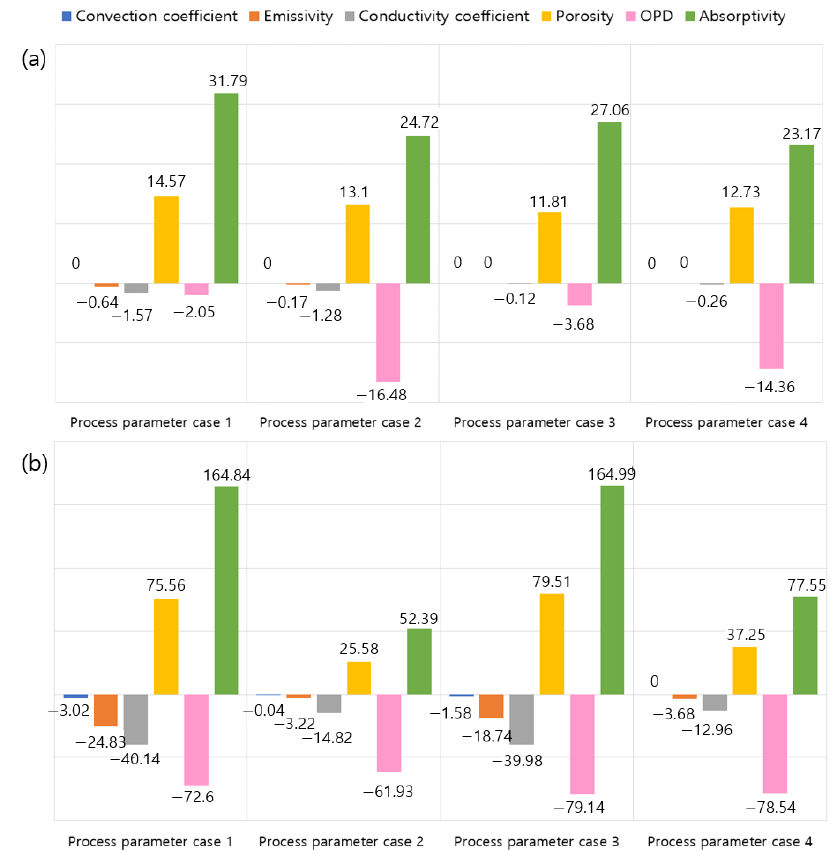
Figure 7. Sensitivity of analysis parameters to: ( a ) melt pool depth; ( b ) melt pool width.